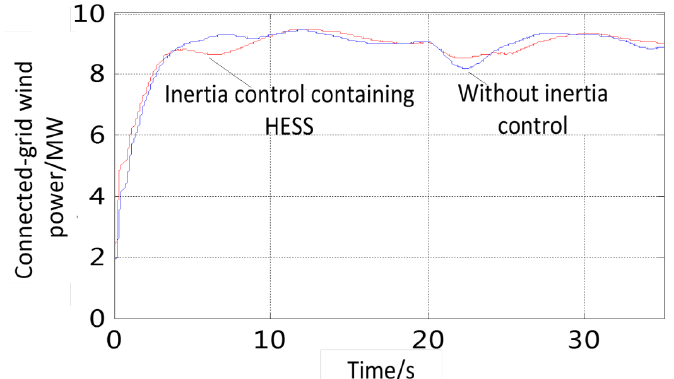
Figure 7. Data analysis for the wind speed fluctuation. ( a ) The wind speed fluctuation of the wind farm; ( b ) The connected-grid power of the doubly fed induction generator wind power system with hydrogen energy storage.